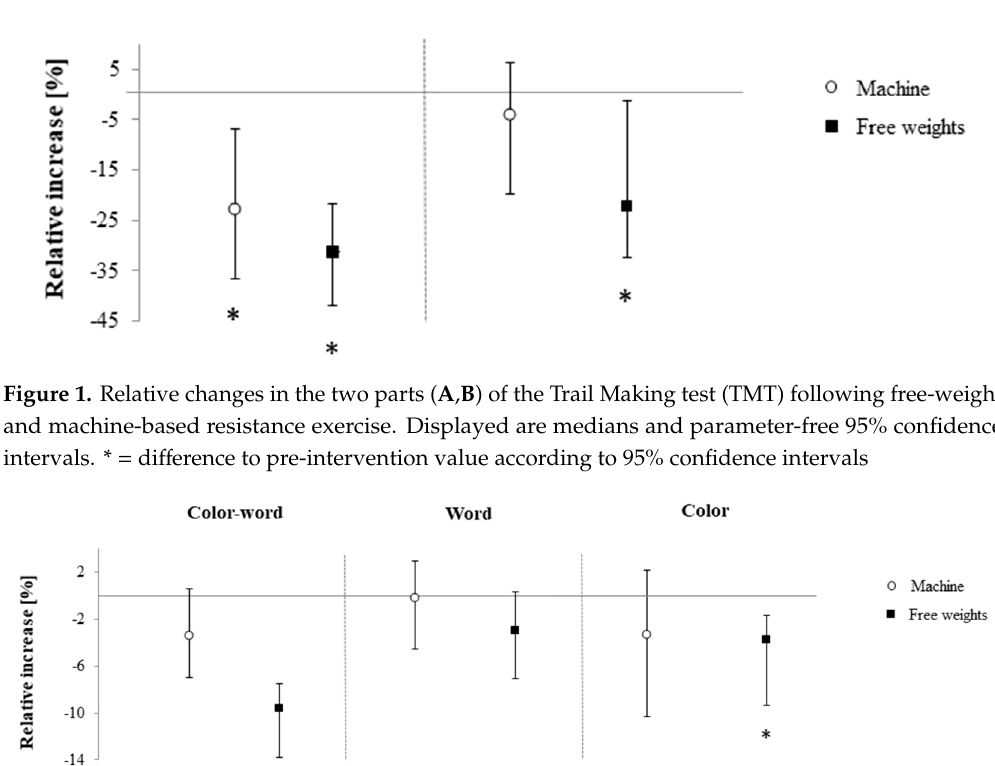
Figure 2. Relative changes in the three conditions of the Stroop test following free-weight and machine-